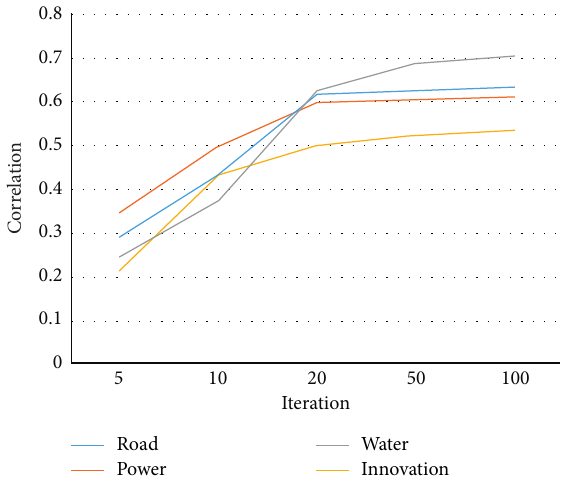
Figure 3: Convergence